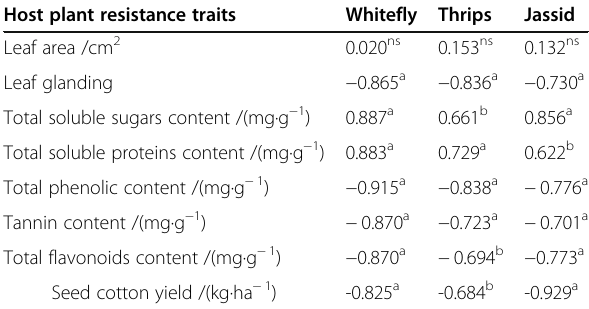
Table 3 Correlation coefficient values between sucking insect pests population (number/leaf) and morpho-biochemical host plant resistance traits across different cotton genotypes Host plant resistance